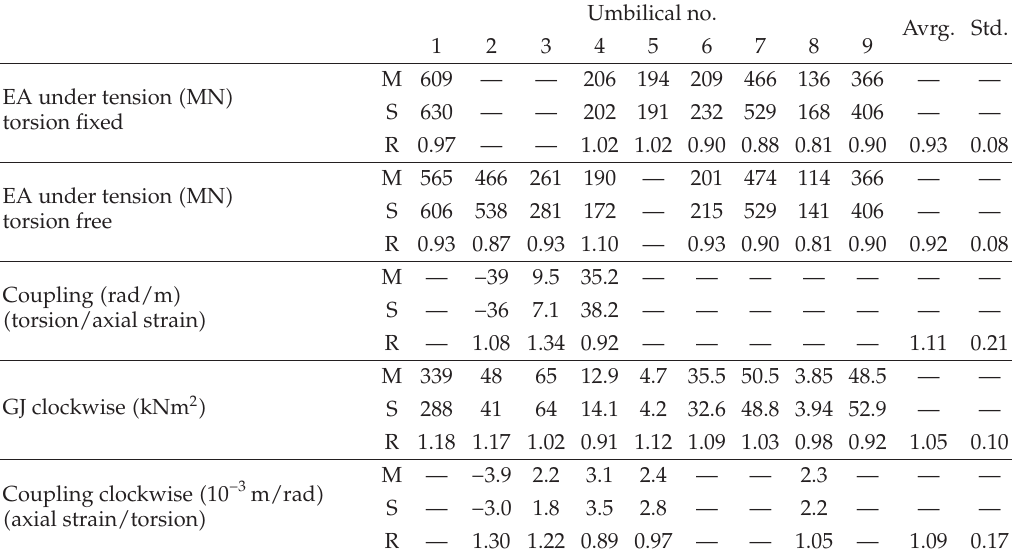
Table 3: Comparing full-scale tests to analysis. Measurements denoted (cid:5) M (cid:6) , simulation results (cid:5) S (cid:6) and measurement to simulation ratio (cid:5) R (cid:6) . Average value and standard deviation are given for the ratio parameter.